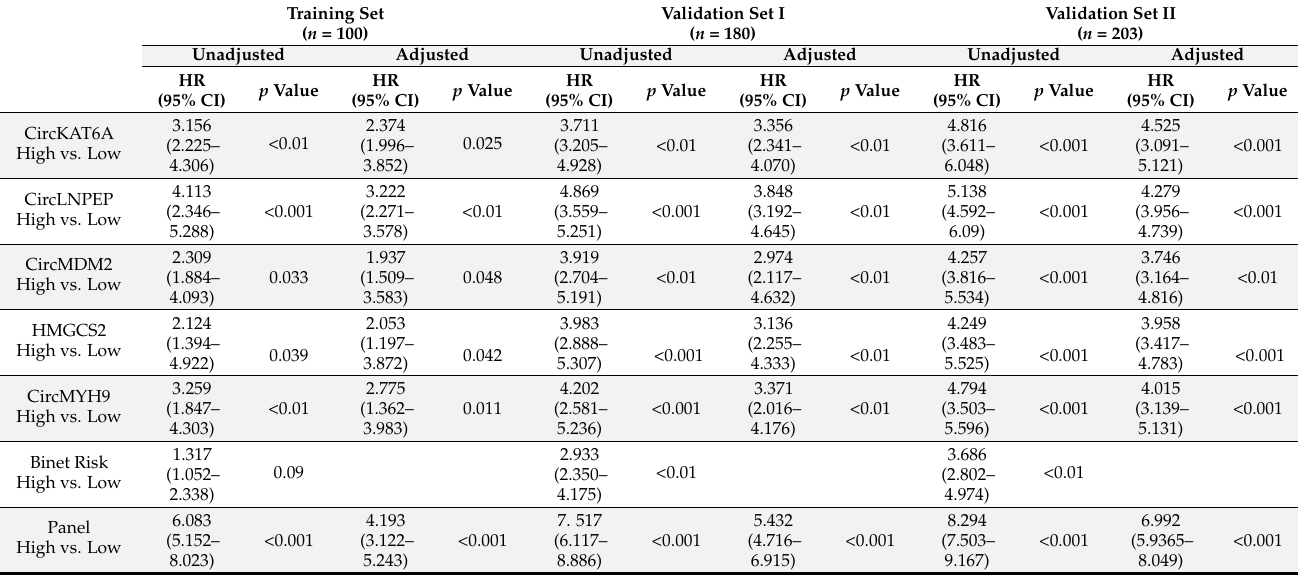
Table 5. Univariate and Multivariate Cox regression analysis of overall survival of circRNAs signature as individual biomarkers and in the form of panels in CLL